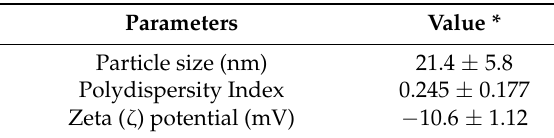
Table 1. Physical parameters of blank